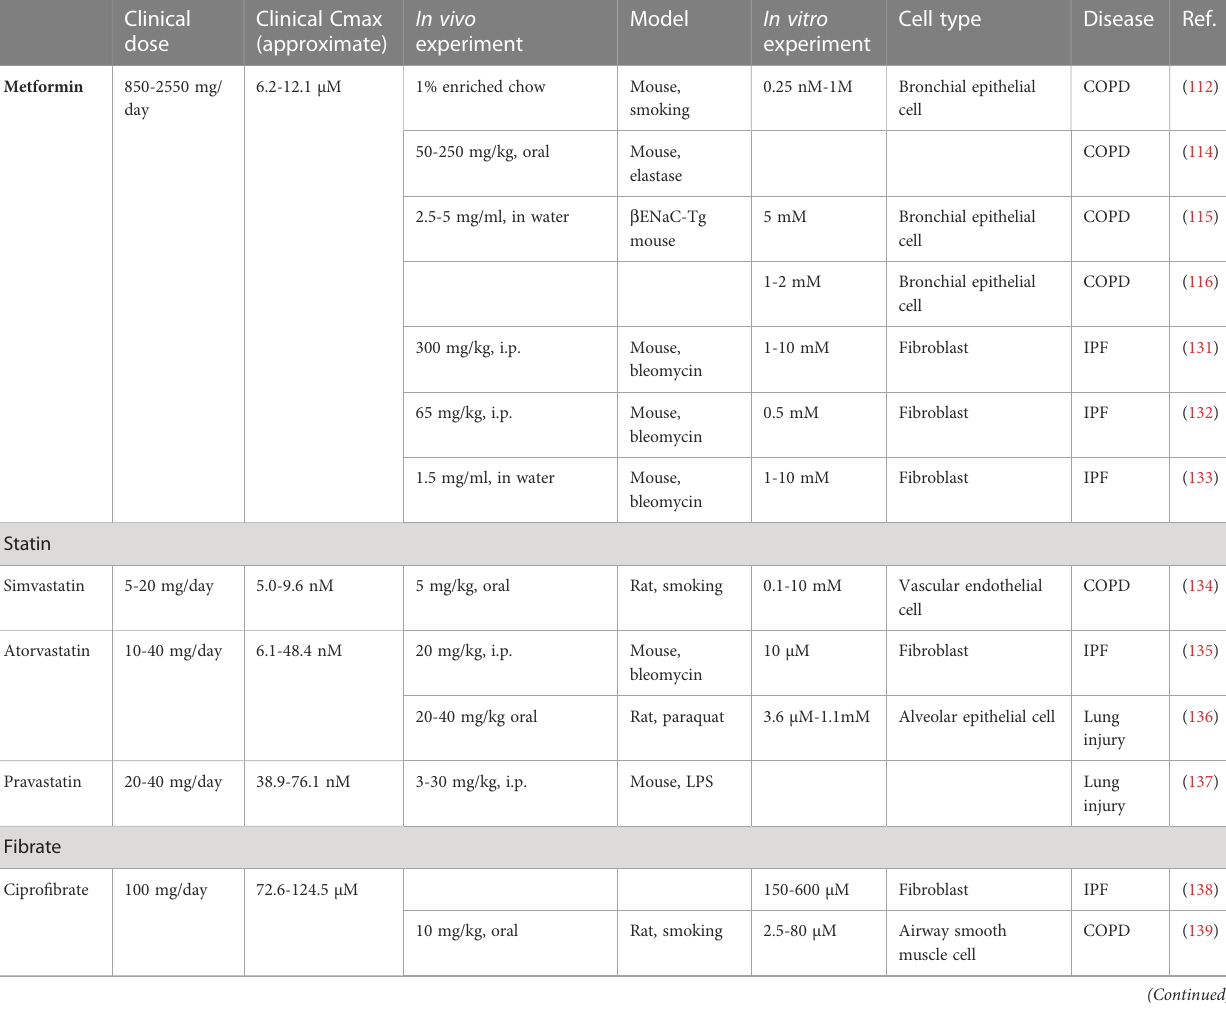
Model In vitro Cell type Disease experiment